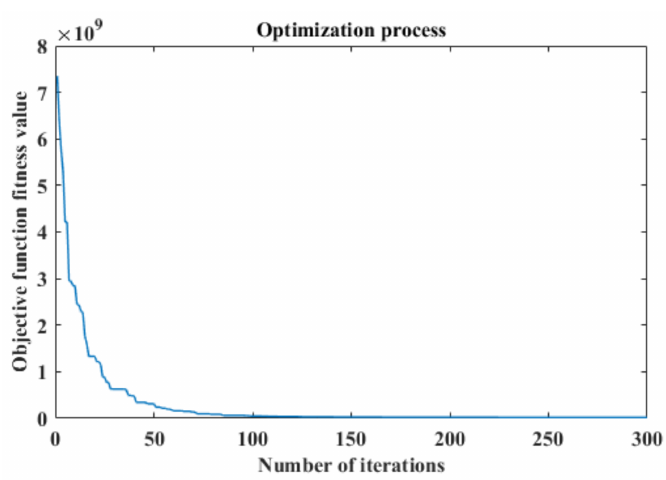
Figure 2. Convergence curve of Dongbo.